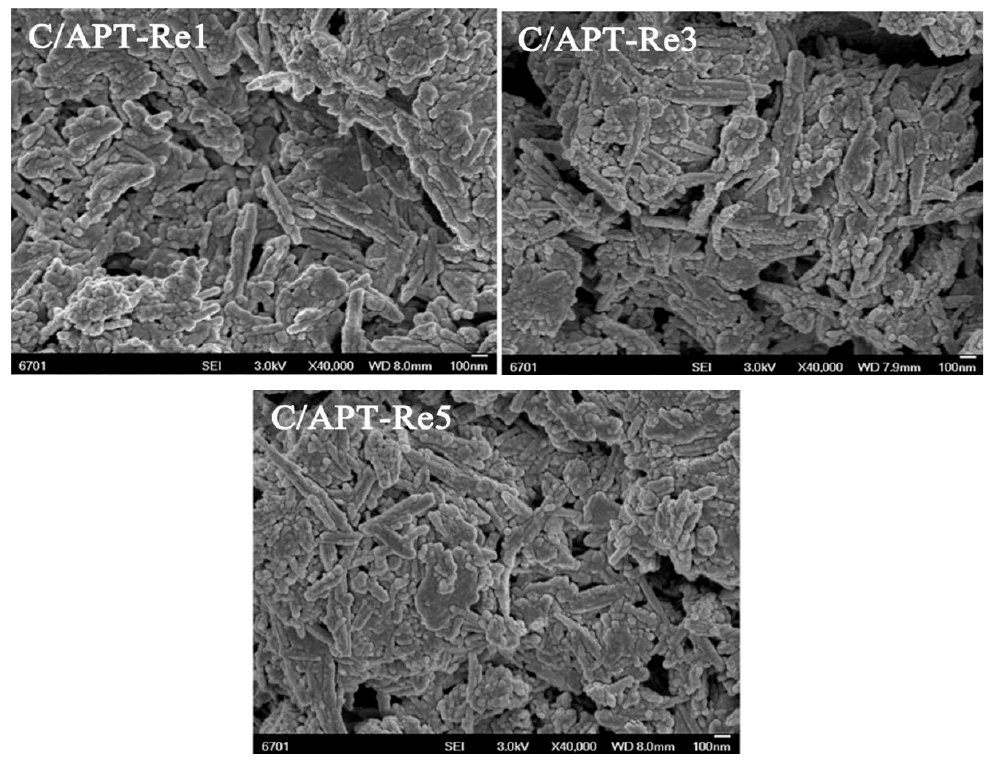
Figure 6. SEM images of C/APT-Re1, C/APT-Re3, and C/APT-Re5.